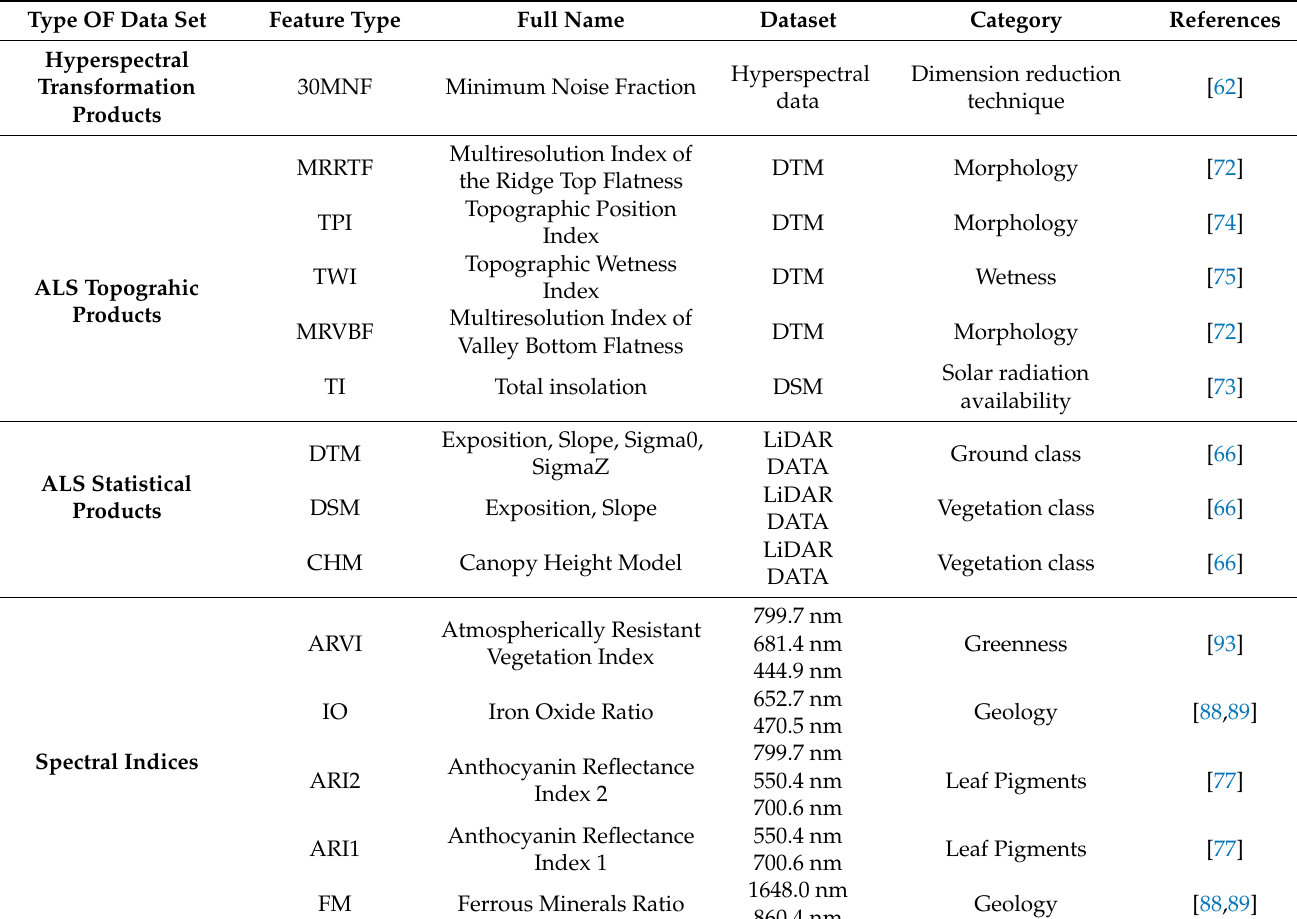
Table 8. Recommended RS sub-products in the identification of transition mires and quaking bogs for transition mires and quaking bogs in the Janowskie Forest (JF